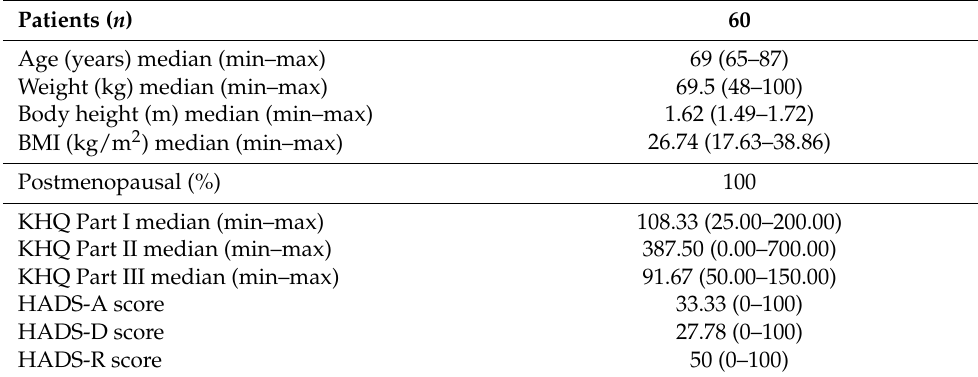
Table 1. Characteristics of the studied group before surgery.